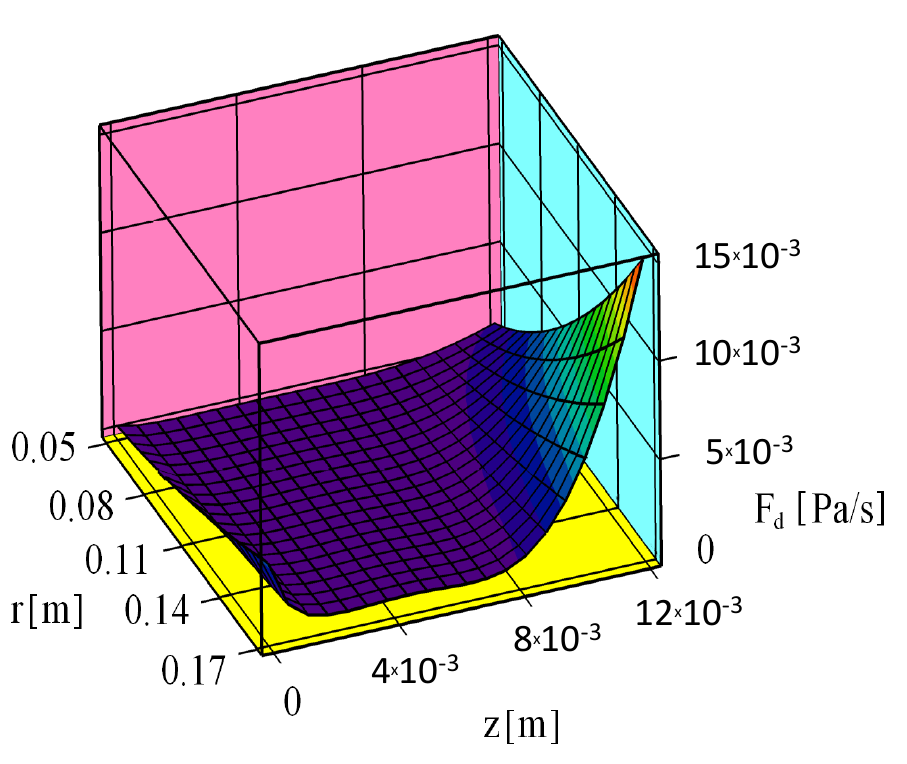
Figure 7. Graph of the dissipation function F d .